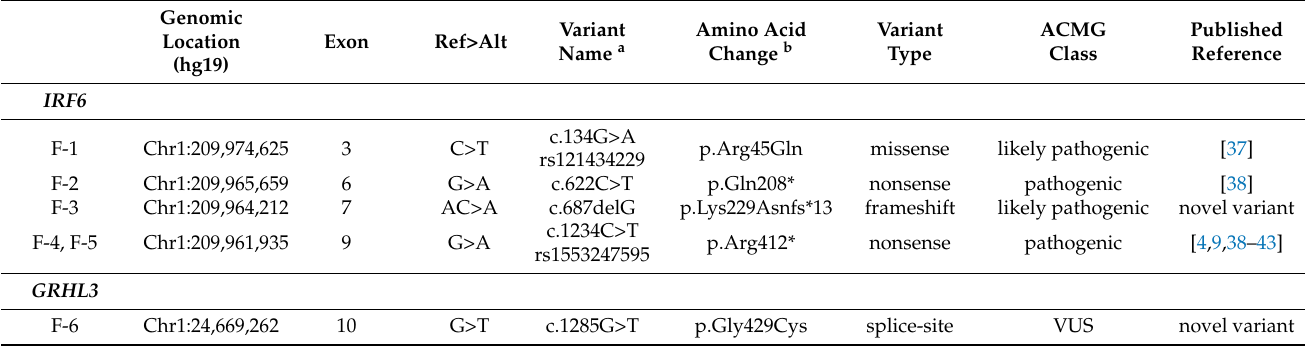
Table 1. IRF6 and GRHL3 variants that confirm the diagnosis of Van der Woude syndrome in six